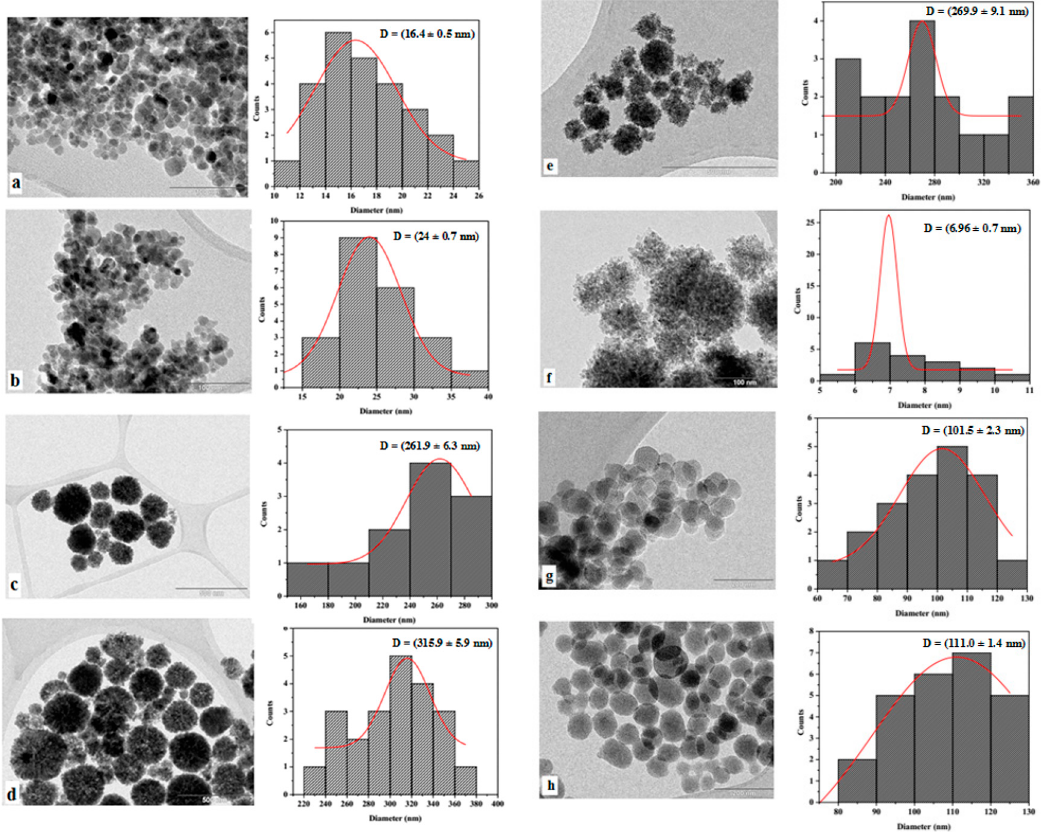
Figure 6. TEM analysis of MNPs and FMNPs for ( a ) Fe 3 O 4 -C, ( b ) Fe 3 O 4 -C@hpbtz, ( c ) Fe 3 O 4 -H, ( d ) Fe 3 O 4 -H@hpbtz, ( e ) Fe 3 O 4 @hpbtz, ( f ) Fe 3 O 4 -H, ( g ) MSNs, and ( h ) MSN-Et 3 N-IPTMS-hpbtz- f1, as well as the corresponding particle size distribution.